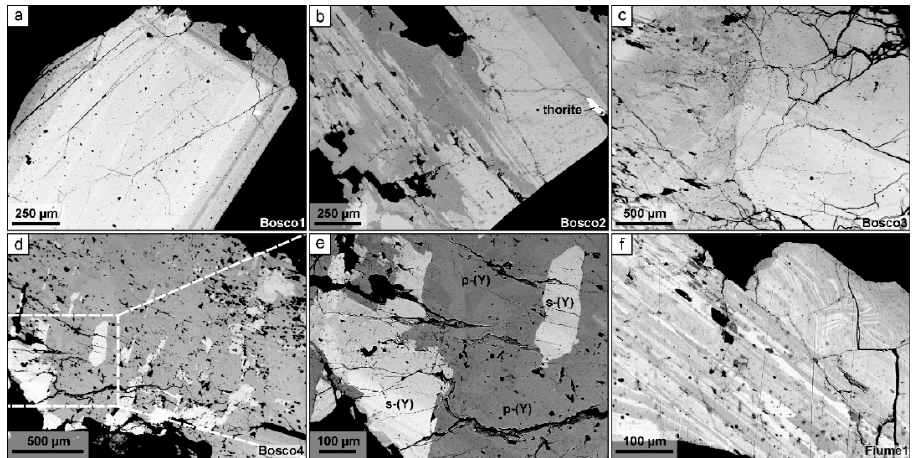
Figure 3. Back-scattered electron images of aeschynite-(Y) in ( a ) and ( b ) (Bosco1 and Bosco2), samarskite-(Y) in ( c ) (Bosco3), in ( d ) the polished section of intergrowth polycrase-(Y) (grey) with samarskite-(Y) (light gray), in ( e ) the detailed sample section (Bosco4), and polycrase-(Y) in ( f ) (Fiume1).